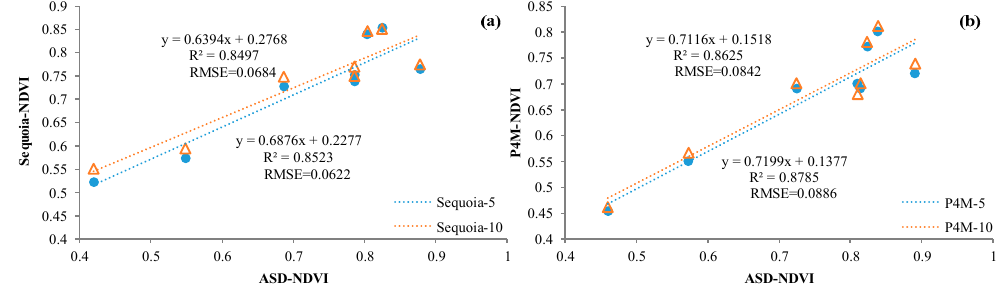
Figure 10. Scatter plots of Sequoia-NDVI ( a ) and P4M-NDVI ( b ) with ASD-NDVI. The blue dotted lines show OLS regression of Sequoia-NDVI (P4M-NDVI) and ASD-NDVI data with 5 cm resolution. The orange dotted lines show OLS regression of Sequoia-NDVI (P4M-NDVI) and ASD-NDVI data with 10 cm resolution.